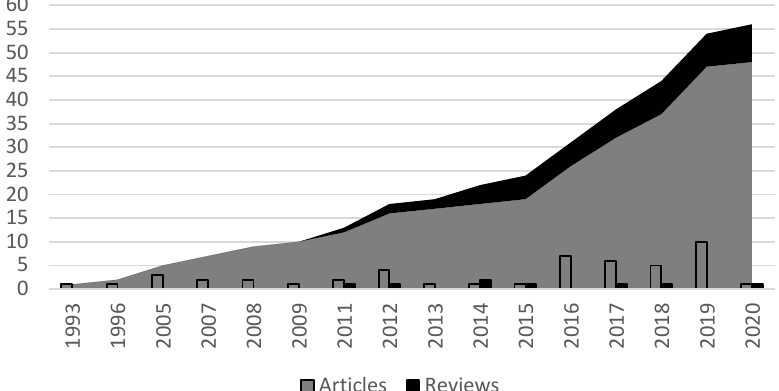
Figure 2. Annual and accumulated value of publications on residential solar heating with flat-plate solar collectors, divided into articles and reviews, from 1993 and 2020.